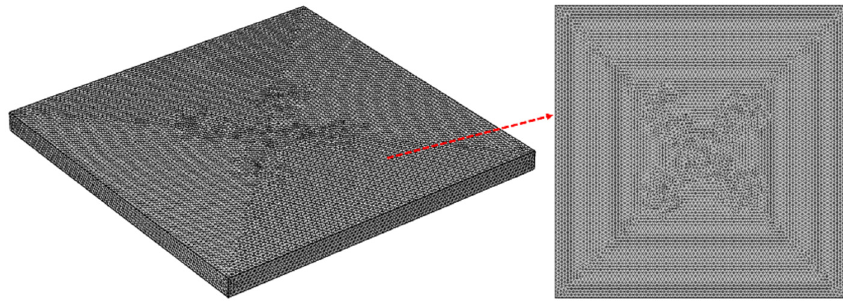
Figure 3. Seamless tetrahedron mesh employed for a 500 × 500 × 28 μ m 3 EBT3 film.